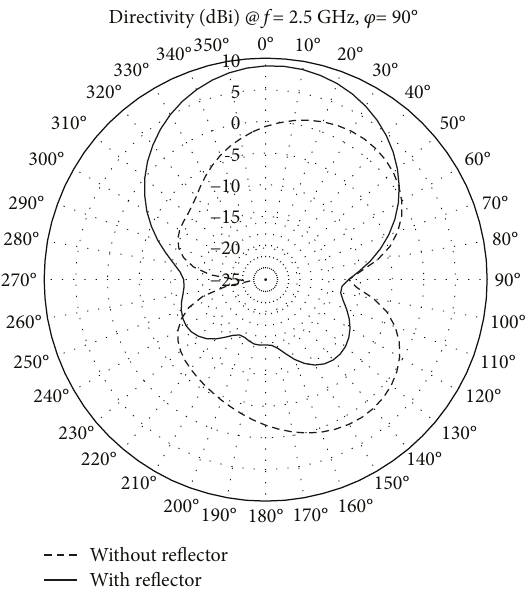
Figure 4: Numerical result comparison between directivity achieved for the antenna without (black dashed line) and with the re fl ector (black line).